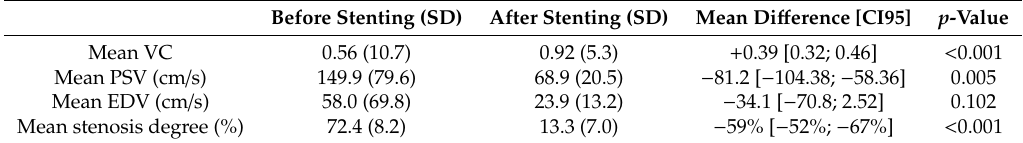
Table 2. Mean values and mean di ff erences between VC, PSV, EDV, and mean stenosis severity. Before Stenting (SD)